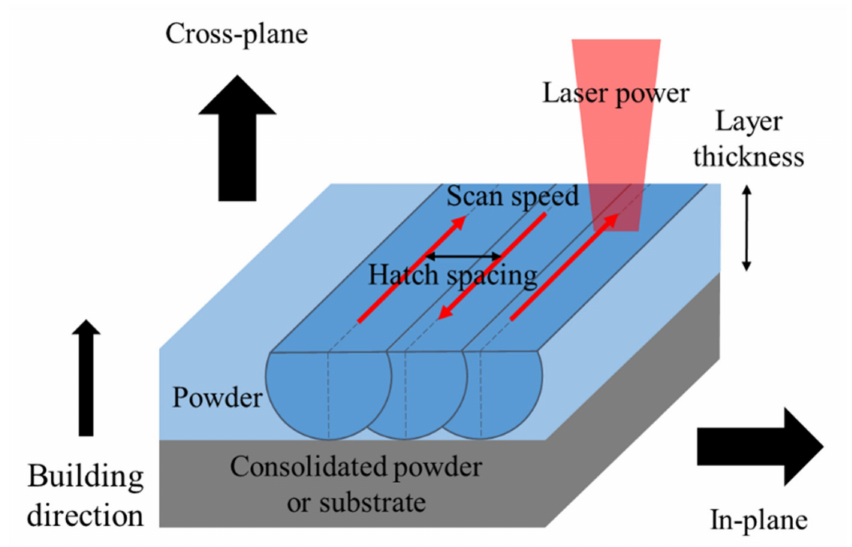
Figure 1. Schematic of parameters for SLM and property measurement